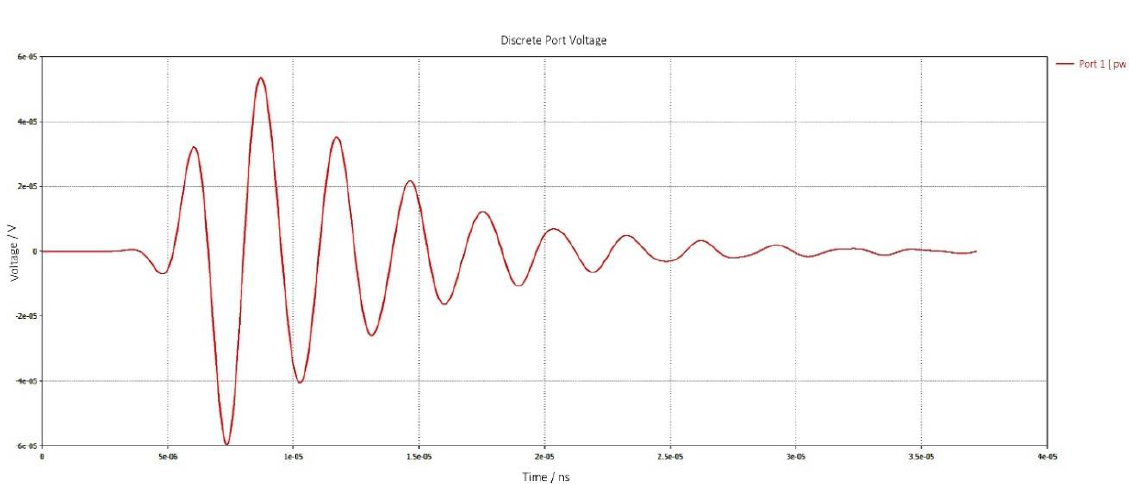
Figure 12. ( a ) Input resistance of the proposed antenna; ( b ) Input Reactance of the proposed antenna.